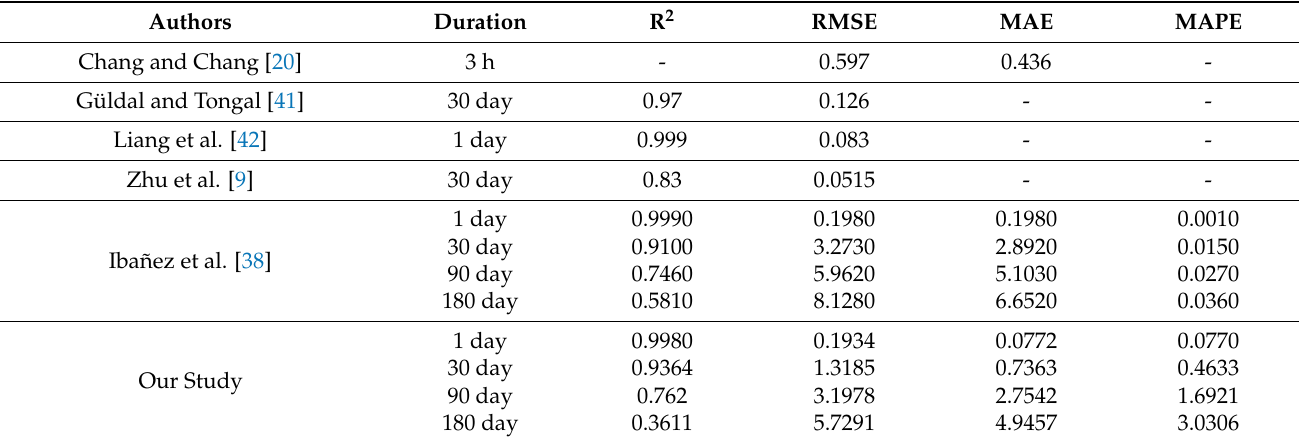
Table 6. Comparison with other water level